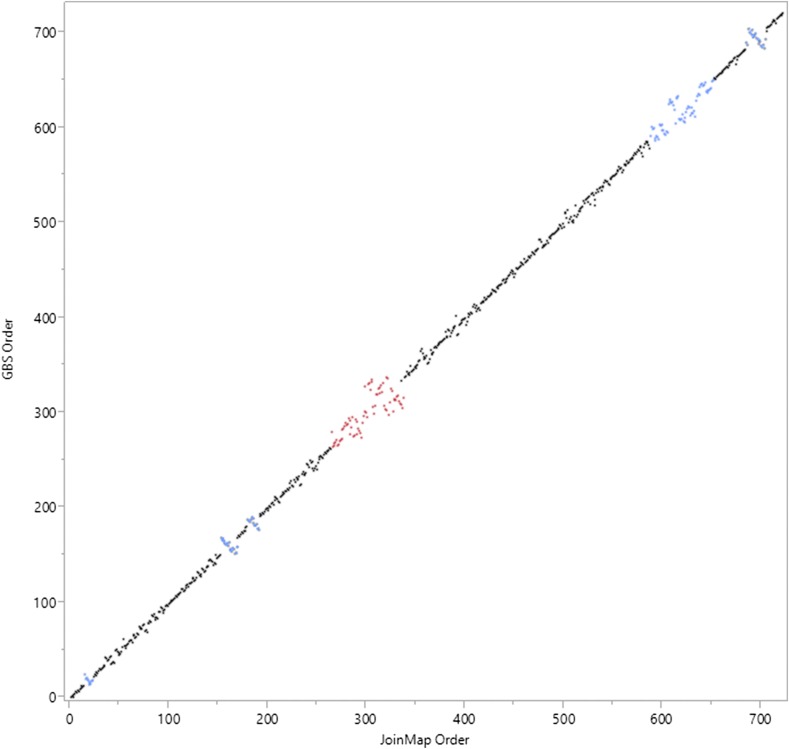
Bivariate comparison between the marker orders according to the reference genome and JoinMap for chromosome 1 following custom filtering. The x-axis represents the order according to the linkage map generated by JoinMap, the y-axis represents the order according to the reference genome v2.4 (GBS ordering). When the slope of the data points is equal to one, the two methods are in agreement on the marker order. Points that do not fall on the line reflect markers that differ in order depending on the method used. The red points represent the centromere and the blue points mark an area of high marker density.